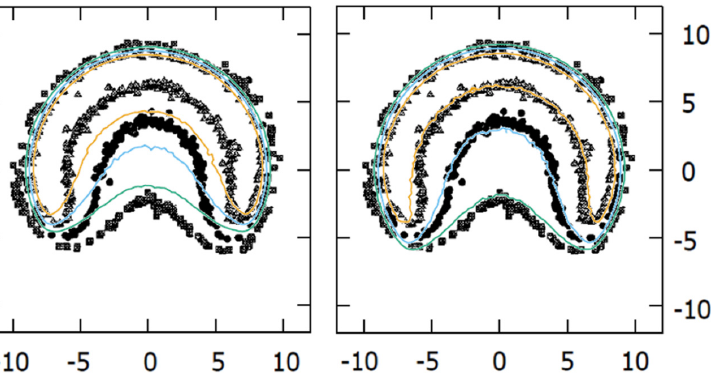
Figure 6. Comparison of isodoses (20%, 30%, and 40% in green, blue, and orange color lines, respectively) at a 4.5 mm depth plane obtained with our MC calculations for the CIB plaque, overlaid on the Taccini et al. 1997 [8] radiochromic film measurements with the official ( left panel ) and modified ( right panel ) geometries.